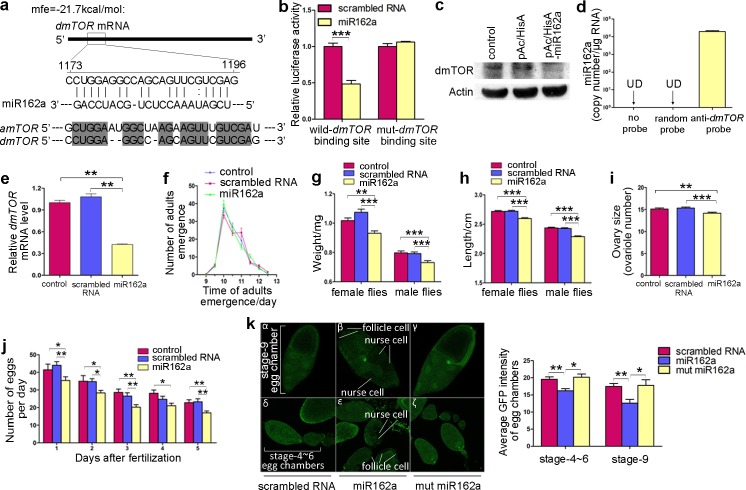
Effects of miR162a on dmTOR gene expression and Drosophila phenotypes.(a) Schematic illustration of the hypothetical duplex formed by the interaction between dmTOR (top) and miR162a (bottom) in Drosophila. The predicted free energy of the hybrid is indicated. The sequences in the binding site are highly conserved across honeybees and Drosophila. (b) Firefly luciferase reporters containing the potential binding site or a mutant binding site for miR162a in the dmTOR gene were co-transfected with scrambled RNA or miR162a into 293T cells. At 24 h post-transfection, cells were assayed using luciferase assay kits. Data are represented as the mean ± SEM. ***p < 0.001, Student’s t-test. (c) Western blotting analysis of the levels of dmTOR protein in control S2 cells or in S2 cells transfected with an empty pAc5.1 vector or with a pAc5.1 vector expressing miR162a. For the expression of miR162a, a fragment containing the miR162a sequence was cloned into the pAc5.1 vector. The image is a representative of three biological replicates. (d) The absolute levels of miR162a in the pull-down products precipitated by the anti-dmTOR probe, random probe or no probe were assessed via qRT-PCR. UD, undetectable. (e) qRT-PCR analysis of the levels of dmTOR mRNA in 3-day-old Drosophila larvae reared with control medium or medium supplemented with synthetic miR162a. Error bars represent SEM. **p < 0.01, one-way ANOVA. (f-j) Developmental time (f), body weight (g), body length (h), ovary size (i) and fecundity (j) of Drosophila reared with control medium or medium supplemented with synthetic scrambled RNA or miR162a (n = 25–35). Data are represented as the mean ± SEM. *p < 0.05; **p < 0.05; ***p < 0.001, one-way ANOVA. (k) Decrease in GFP levels in the egg chambers of pUbi-GFP-dmTOR transgenic Drosophila when miR162a was added to the larval diet. The miR162a binding sequence in the dmTOR gene was fused downstream of the GFP reporter gene in a pUbi-GFP expression vector, and a pUbi-GFP-dmTOR transgenic Drosophila line was created via embryo injection. Differences in GFP expression in nurse cells and follicle cells of stage-9 egg chambers (α-γ) or stage-4~6 egg chambers (δ-ζ) were observed when miR162a or mutant miR162a was added to the larval diet of the transgenic line, respectively. Left panel: representative images; Right panel: quantitative analysis (n = 12).